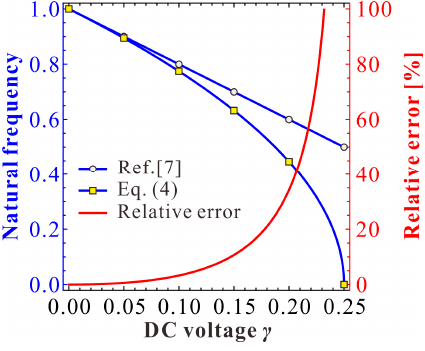
Figure 8. Nondimensional comparison depicting the natural frequency versus DC voltage.